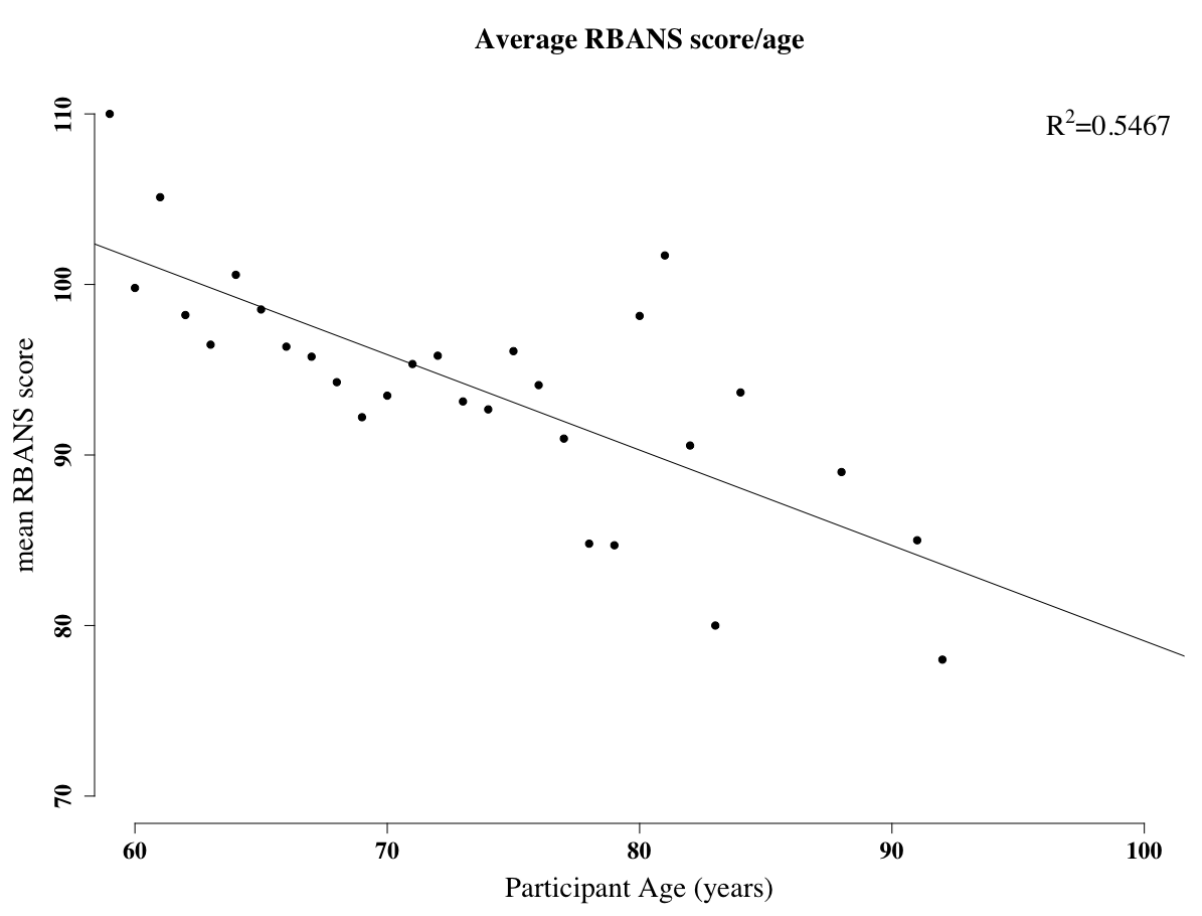
Figure 5. Mean Repeatable Battery for the Assessment of Neuropsychological Status (RBANS) score as a function of participant’s age. The graph shows a general decrease in the RBANS score as age increases. RBANS scores have been averaged by age; thus, each point represents the average score for any particular age. One outlier existed for age=86. This was removed and the R value recalculated